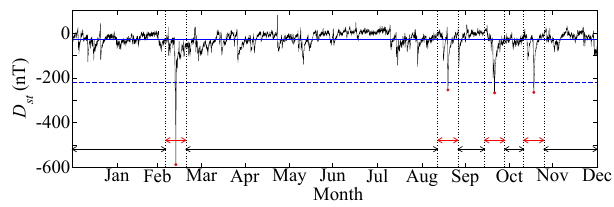
Figure 2. Storm and quiet states in the Dst time series for 1989, also indicating the average value of the Dst index (horizontal line), and the threshold used to identify storms (dashed line). Red (black) arrows indicate storm (quiet) states. (Taken from Domínguez et al., 2014.)